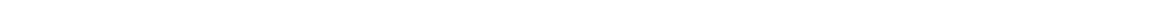
Table 1). We narrowed down the list of homologs to 15 genes with a DIOPT score of 3 or greater, or in the case of KIF22 klp68D , high query coverage and percentage identity in BLAST. Of the 15 selected homologs, RNAi lines were available for all homologs except INO80E , and therefore we were unable to characterize this gene. Therefore, 14 homologs of 16p11.2 genes were used in this study. We used a similar strategy for identifying homologs for other genes tested for interactions in this study. We con fi rmed that all tested 16p11.2 homologs were expressed in the fl y eye using database and literature searches (Supplementary Table 1).